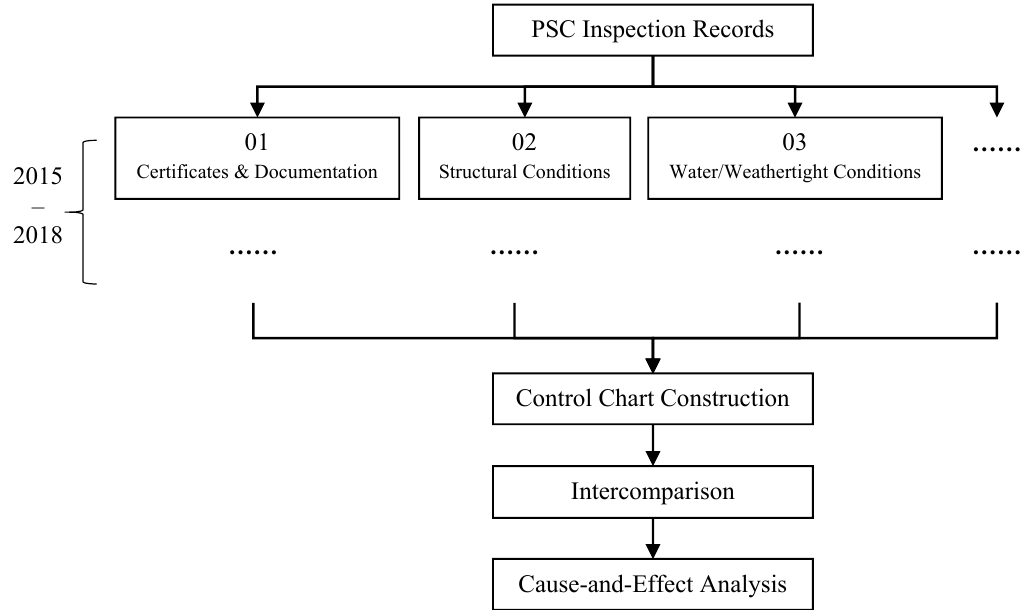
Figure 3. Statistical process control (SPC) analysis framework.